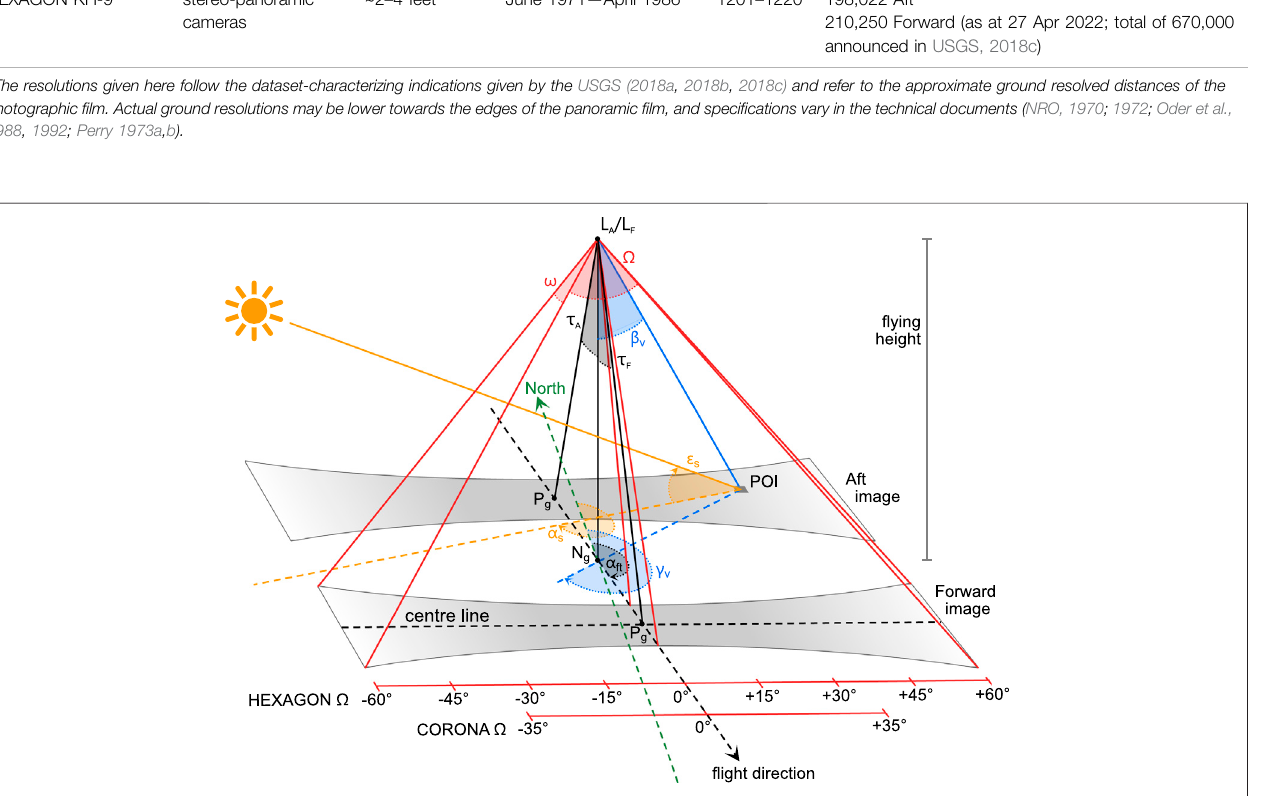
FIGURE 1 | Schematic diagram of images taken with the stereo-panoramic cameras of the CORONA and HEXAGON programs, showing exemplary image footprints of the maximum possible 120 ° HEXAGON scan width. Forward diagram shows image geometry; L A /L F : exposure stations of dual camera system; Ω : across- track camera fi eld of view; ω : along-track camera fi eld of view; τ A / τ F : camera tilt angle against/towards fl ight direction; α ft : azimuth of fl ight track towards North; N g : ground nadir point (vertical projection of L onto the ground); P g : ground principal point (projection of optical image centre on the ground). Aft diagram